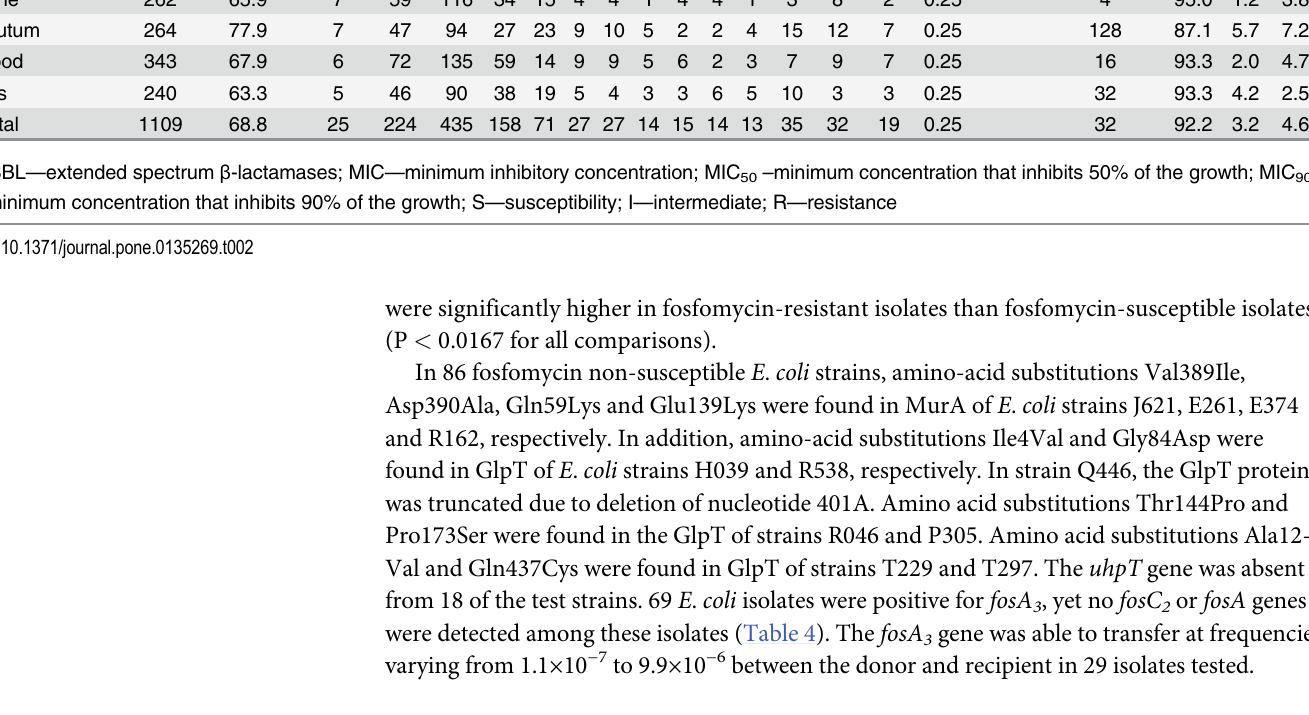
Table 2. Fosfomycin susceptibility of E . coli strains from different samples by source. Sample source